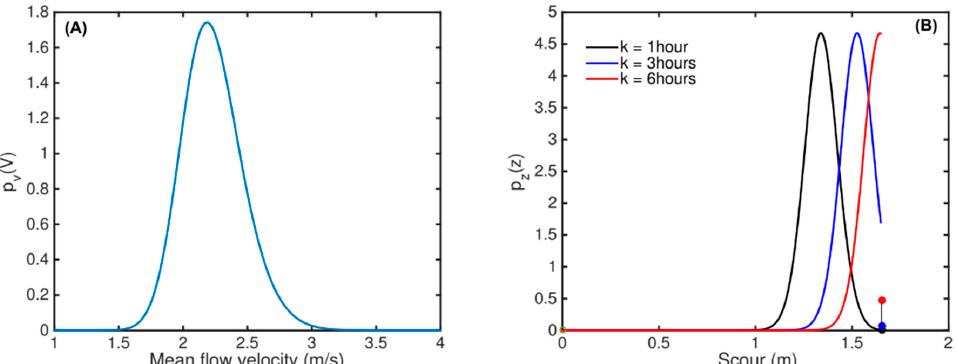
Figure 4. Derived probability density function of the mean flow velocities associated with a given river basin ( A ) and the corresponding PDFs of scour depth ( B ) obtained assuming hydrographs with variable equivalent duration k , ranging from 1 to 6 h. Other parameters are: D = 1.07 m; d 50 = 0.001 m; ρ s = 2.65 t/m 3 ; u c = 0.319 m/s; λ = 4.7252 × 10 3 ; W * max = 1.8613 × 10 5 ; S = 8.9026; α = 67.8627 m 3 /s; b 1 = 143.643; γ = 0.33; ξ = 0.36 1/m 2